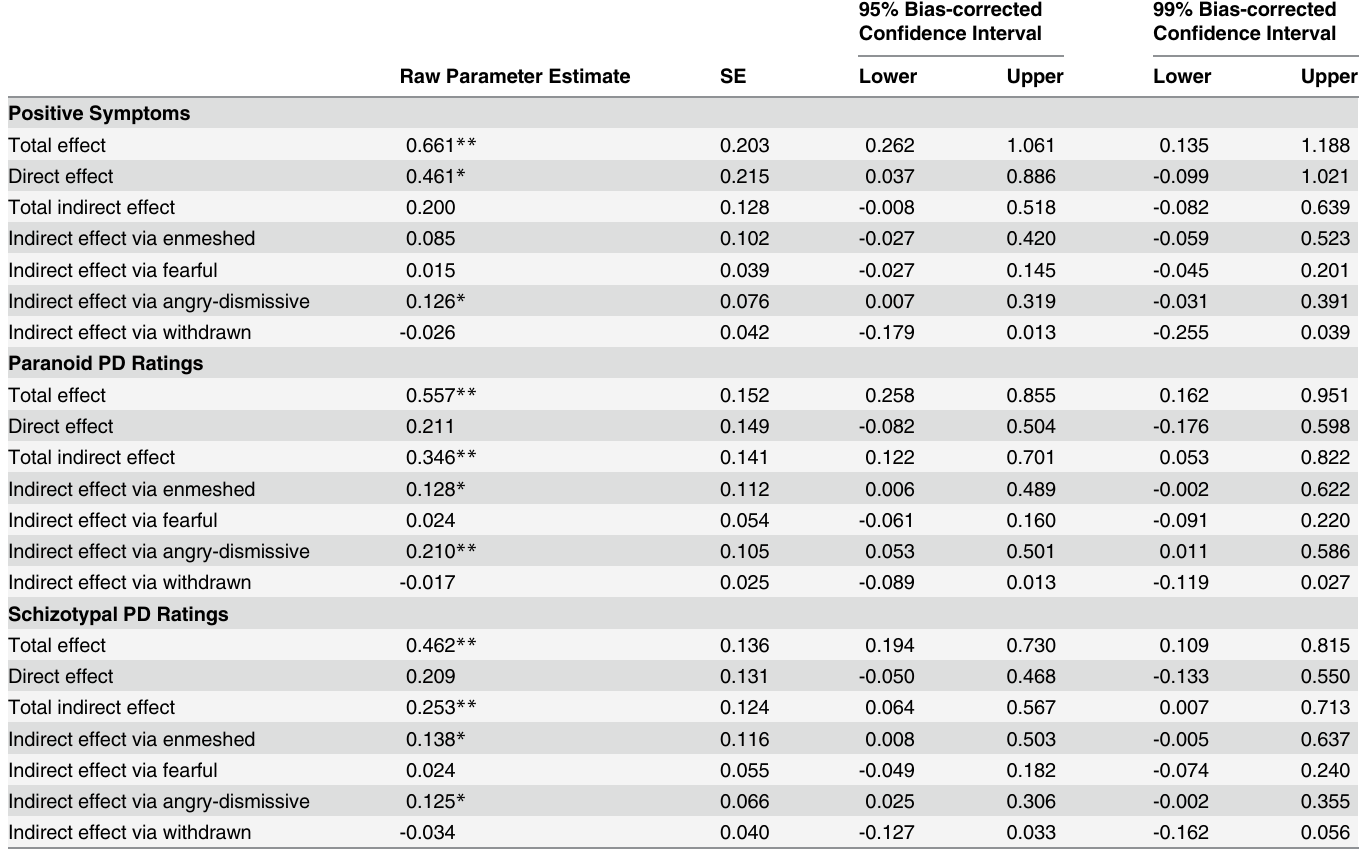
Table 4. Mediation Analyses Examining Indirect Effects of Antipathy on Schizophrenia-Spectrum Phenomenology via Enmeshed, Fearful, Angry- Dismissive, and Withdrawn